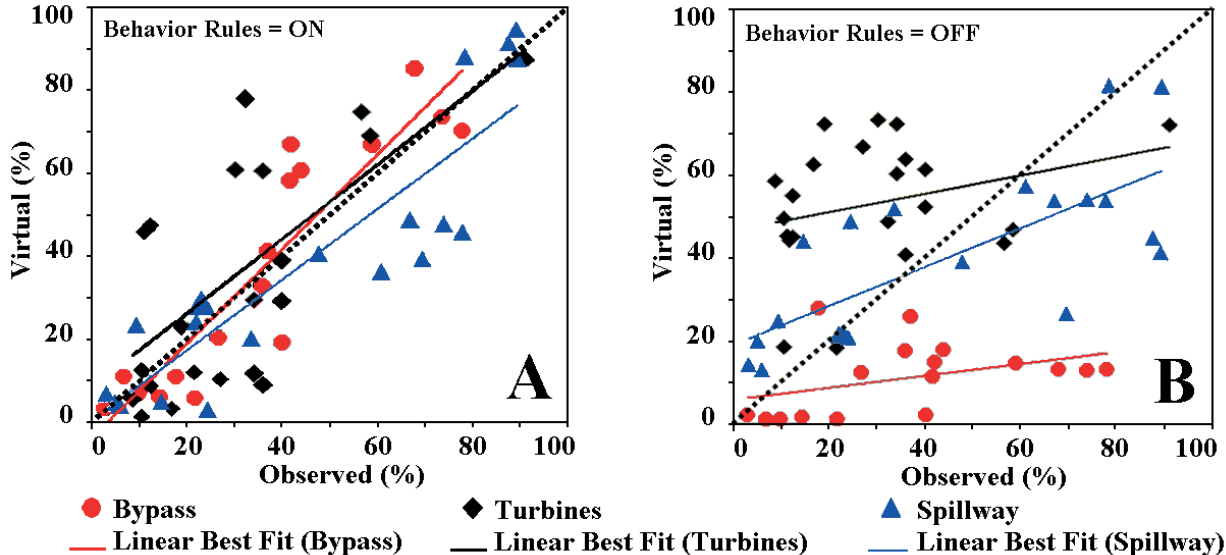
Fig. 1. Comparison of observed and NFS predicted (based on 5,000 virtual fish) emigrant passage proportions for 23 configu- rations for behavior rules turned on (A) and behavior rules turned off (B) (virtual emigrants act as passive particles). Passage (exit) routes are bypass, spillway and turbines. Routes with either 0% or 100% of river flow in CFD model are not plotted or factored into trend lines. Sources of observed data are described in Goodwin et al .